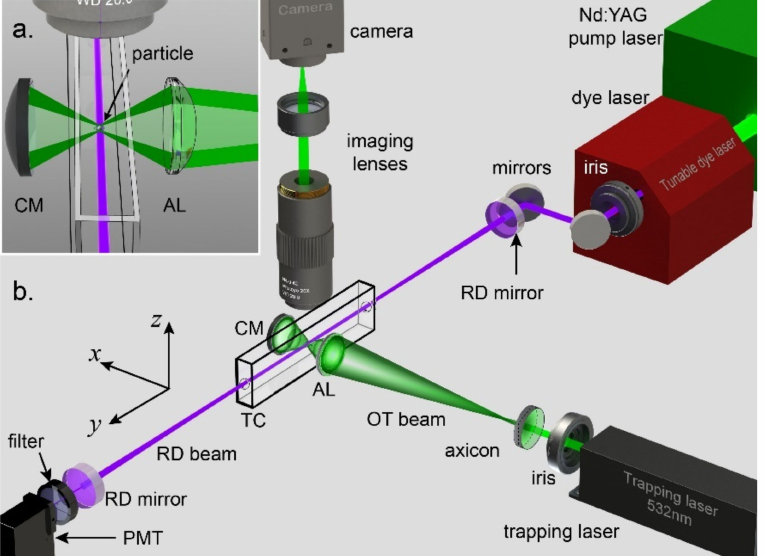
Figure 5. Experimental scheme of the optical trap-cavity ring-down spectroscopy (OTCRDS) system. CM: concave mirror, AL: aspheric lens, RD mirror: ring-down mirror, RD beam: ring-down beam, OT beam: optical trapping beam, TC: trapping cell, PMT: photomultiplier tube. The inset figure illustrates the detailed optical field near the trapping zone. (Reprinted with permission from [139] under Open Access Publishing Agreement. Copyright (2017) The Optical Society of